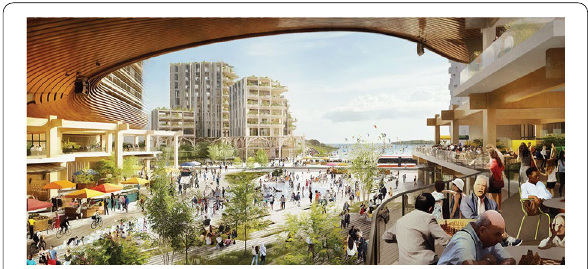
Fig. 4 Heatherwick Studio’s impression of Sidewalk Labs, 2020. © Sidewalk Labs